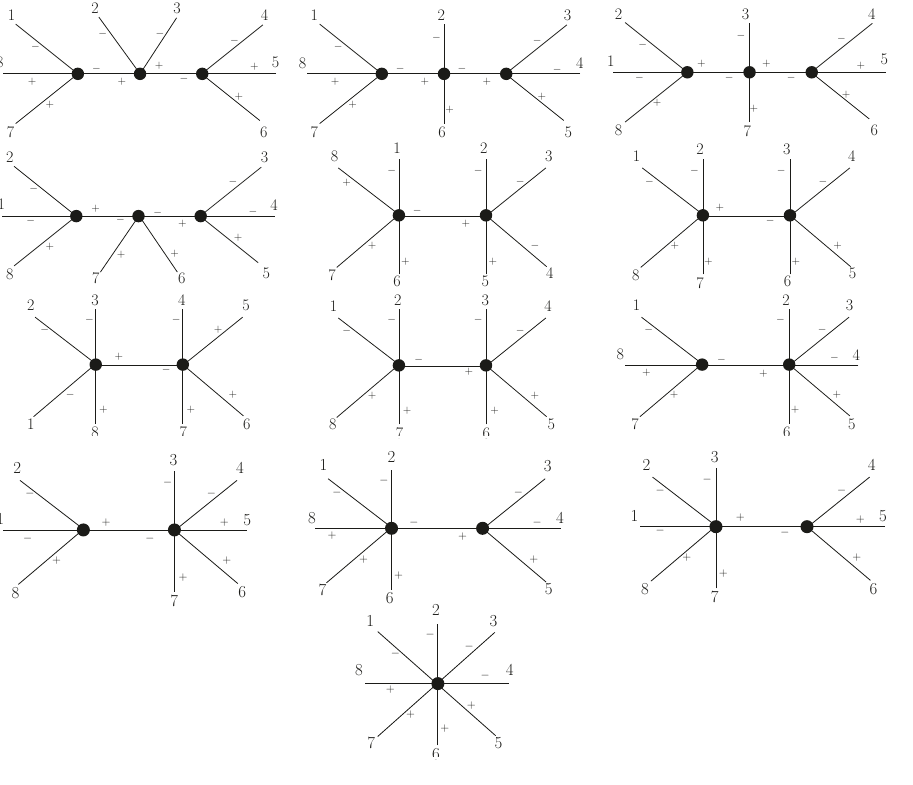
Figure 8 . Diagrams contributing to the 8-point NNMHV amplitude ( − − − − + + ++)